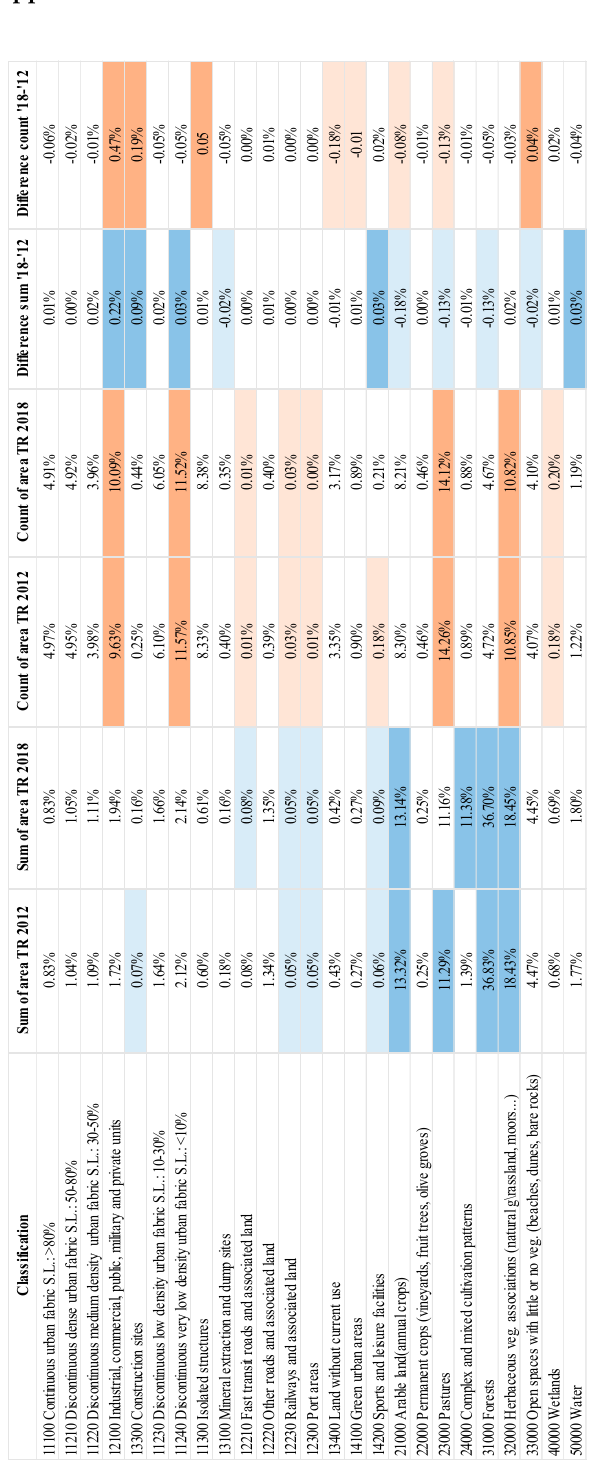
Figure A1. Total area and count of patches of Tirana for 2012–2018 and differences, showing the four highest and four lowest values.